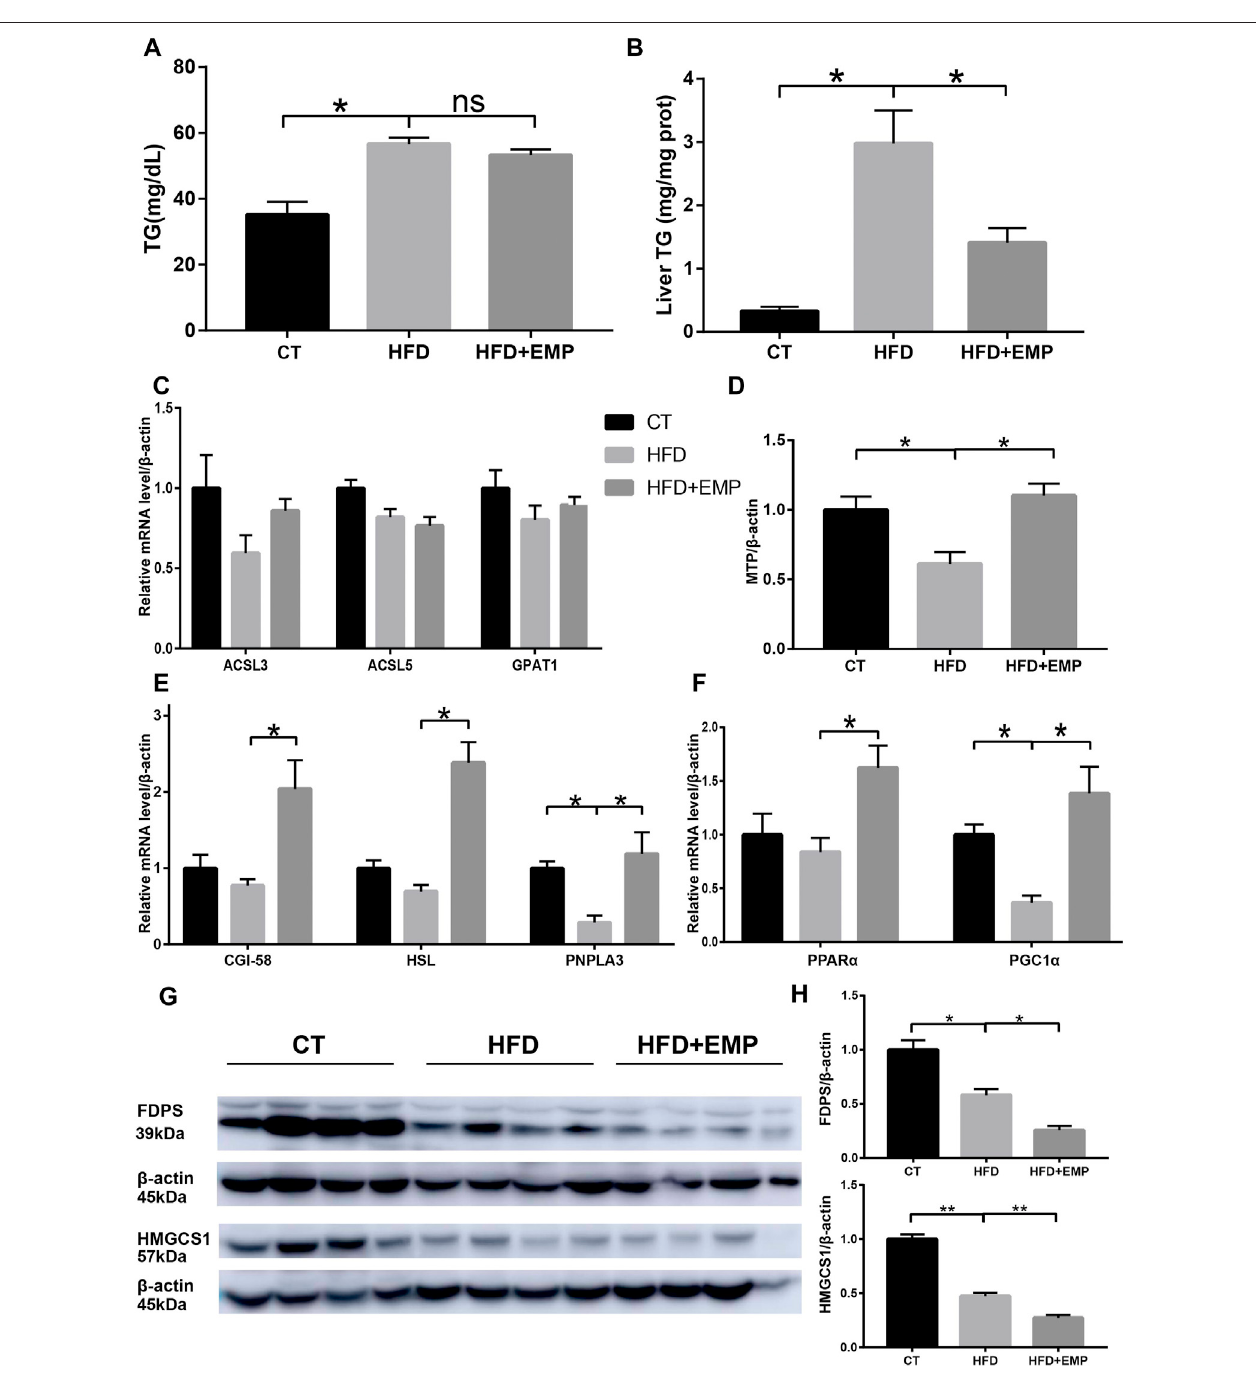
FIGURE 7 | Empagli fl ozin reduced triglyceride level both in serum (A) and liver (B) through enhanced triglyceride transfer (D) , lipolysis (E) and microsomal mitochondrial β -oxidation (F) . Empagli fl ozin had no effect on the synthesis genes of triglyceride (C) . Western-blot analysis showed the protein levels of FDPS and HMGCS1 (GandH) ,whichwerethemostrelevantgenesinlipidmetabolism.Equalloadingofproteinwasveri fi edbyprobing β -actin.Datarepresentmeans ± SEM.* p < 0.05, ** p < 0.01, n (cid:1) (4 – 6).